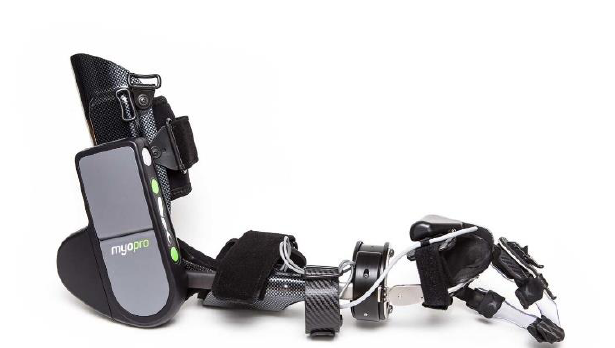
Figure 1. MyoPro 2.0 Motion-G Upper Extremity Orthosis.